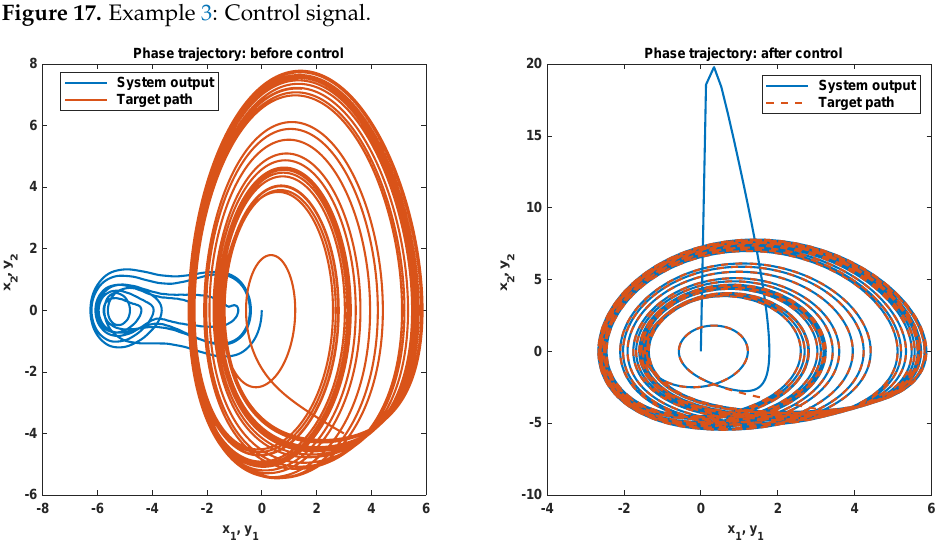
Figure 17. Example 3: Control signal.